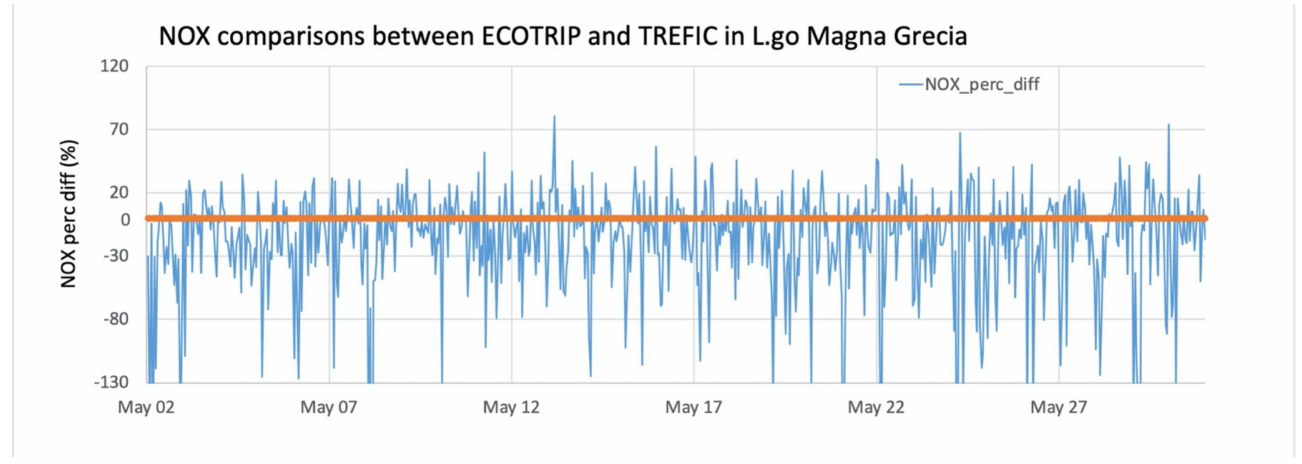
Figure A2. Comparison between Sim 2 and Sim 3 in terms of percentage difference. The orange line indicates the zero.